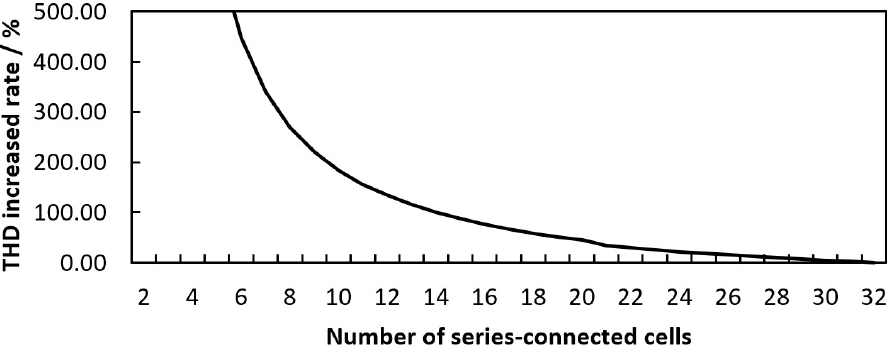
Figure 11. The increased rates of THDs of battery packs with different numbers of cells.